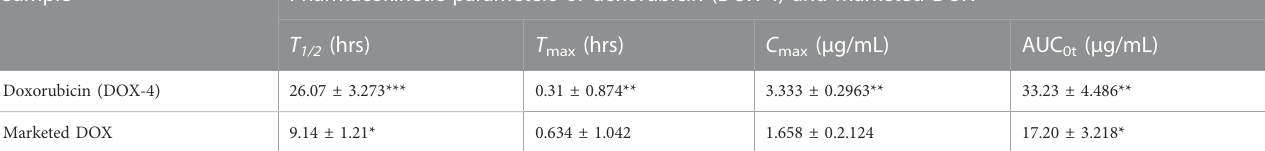
TABLE 4 Pharmacokinetic parameters of Doxorubicin (DOX-4) and marketed DOX. Sample